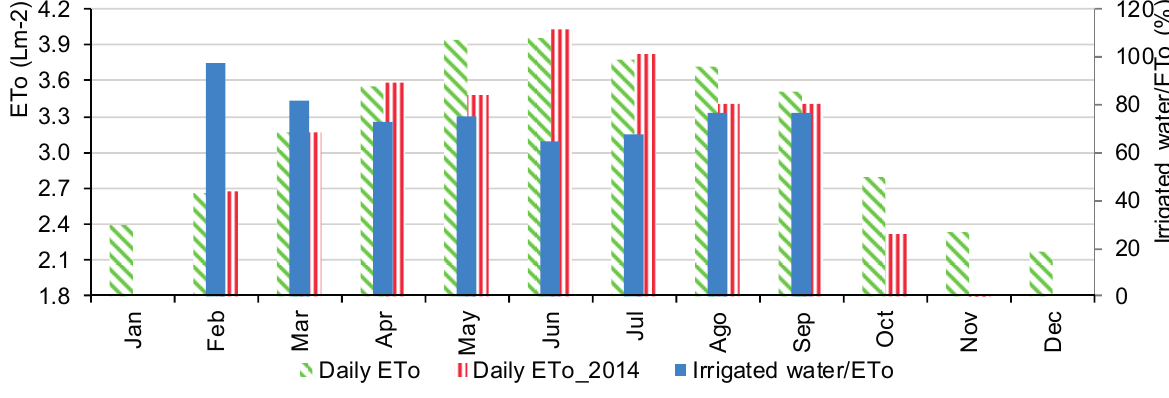
Figure 1. Average reference crop evapotranspiration (ET 0 ) for available 14 years ( green ), daily ET 0 from the experimental period 2014 ( red ) and irrigated water/ET 0 in % ( blue ).